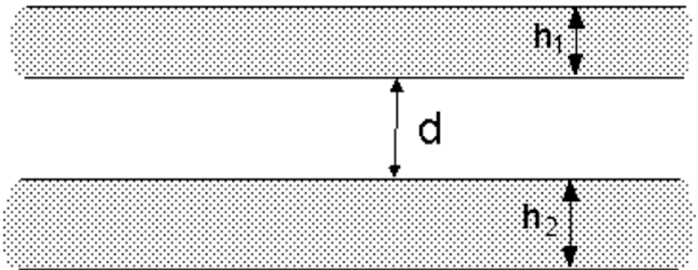
Figure 6. Structure of graphene-wrapped SiC nanoparticles randomly selected at different rotational speeds in HRTEM. ( a ) 160 rpm; ( b ) 200 rpm; ( c ) 240 rpm; ( d ) 280 rpm.